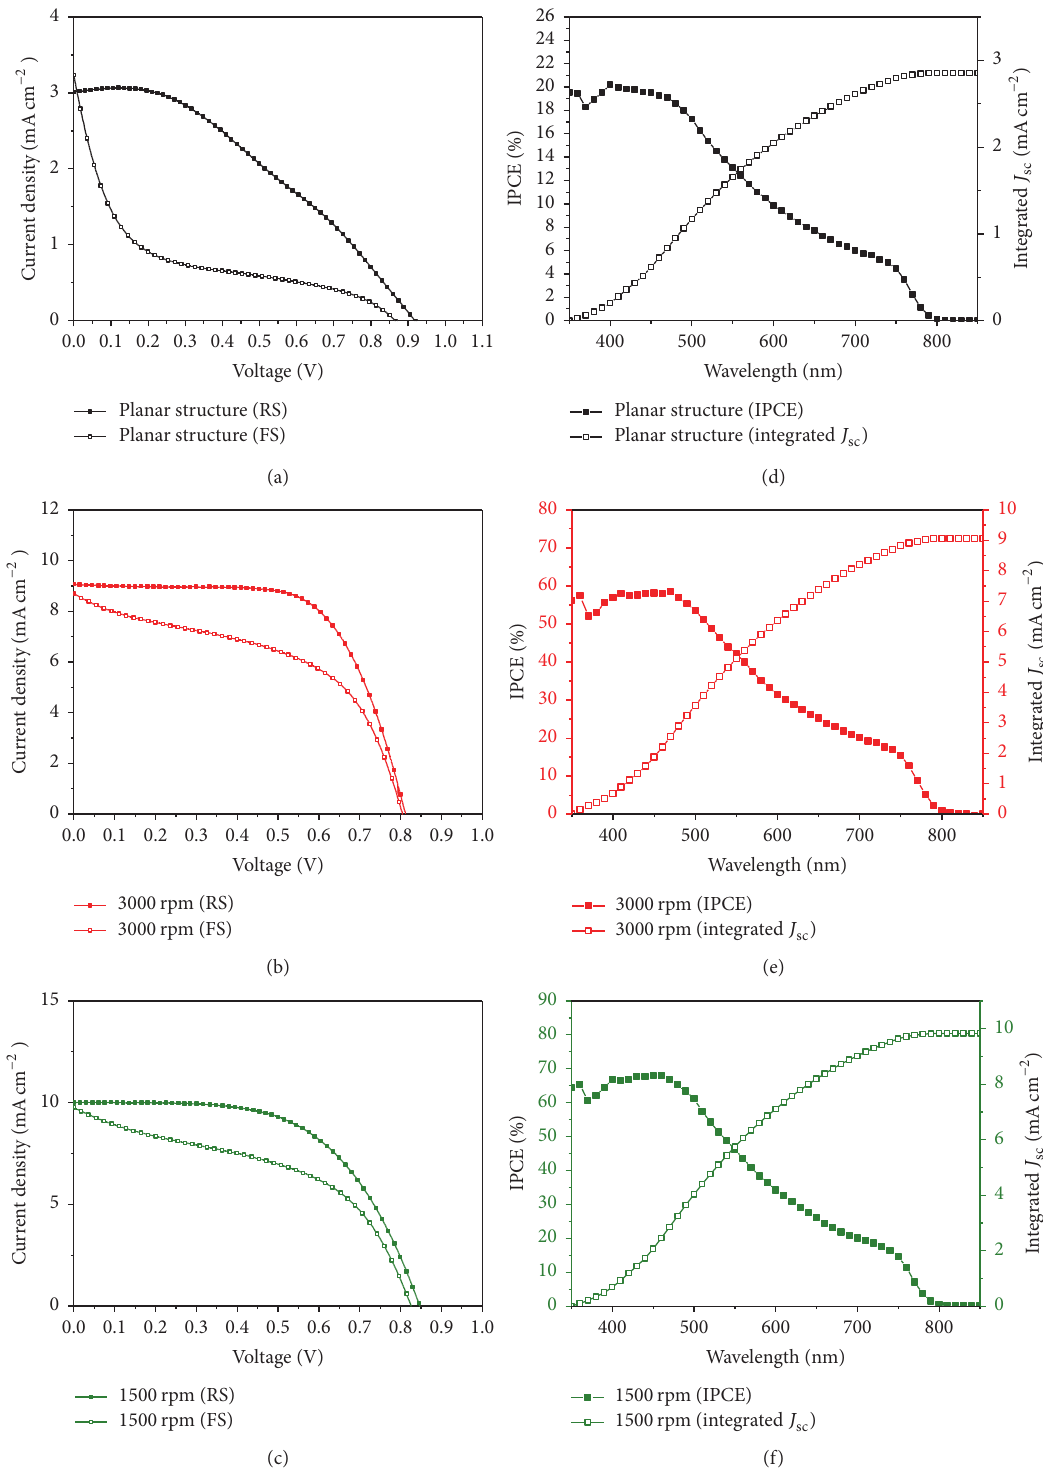
Figure 8: 𝐽 - 𝑉 curves of the CH 3 NH 3 PbI 3 perovskite solar cells with (a) planar structure and the spin-coating rate of the mp-TiO 2 precursor for(b)3000 rpmand(c)1500 rpm.ThecorrespondingIPCEspectrumandtheintegratedshortcircuitcurrentdensity( 𝐽 perovskite solar cells with (d) planar structure and the spin-coating rate of the mp-TiO 2 precursor for (e) 3000 rpm and (f) 1500